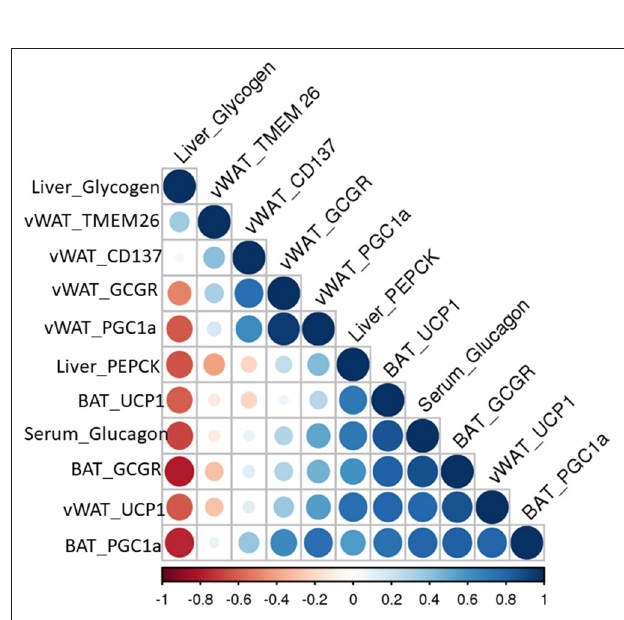
FIGURE 8 | Pearson correlation matrix between glucagon mediated effects and energy expenditure related parameters observed in this study.